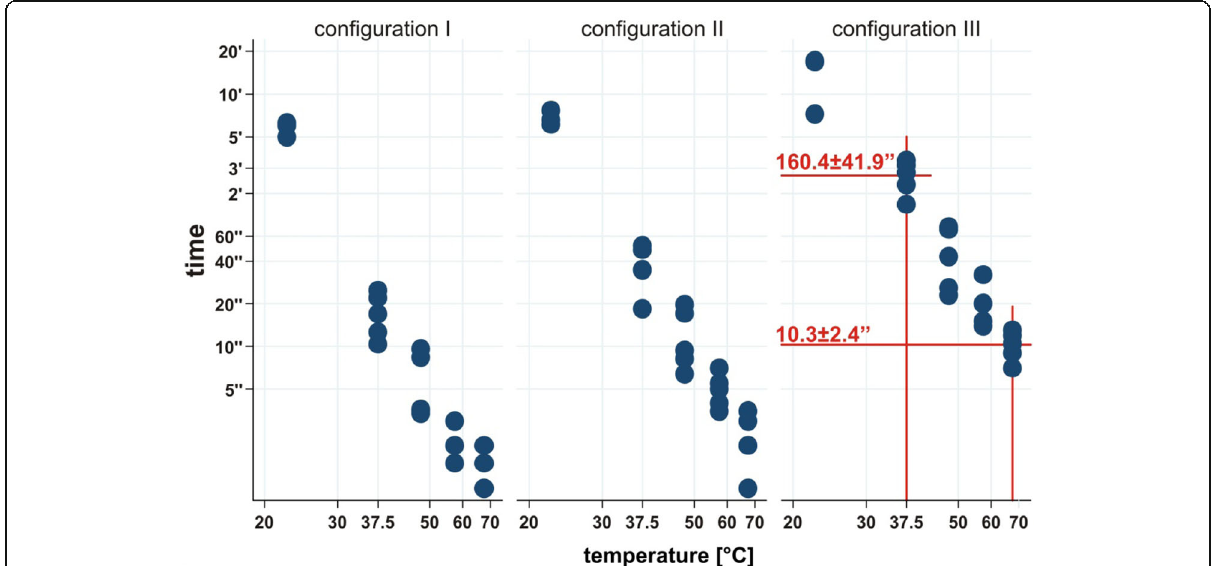
Fig. 2 Temperature-induced HydroCoil configuration changes. Scatter plots of time needed to reach a specific coil configuration as a function of temperature. Note the use of a double logarithmic scale. The time points at which Configuration III was achieved at 37 °C and 70 °C are highlighted in red